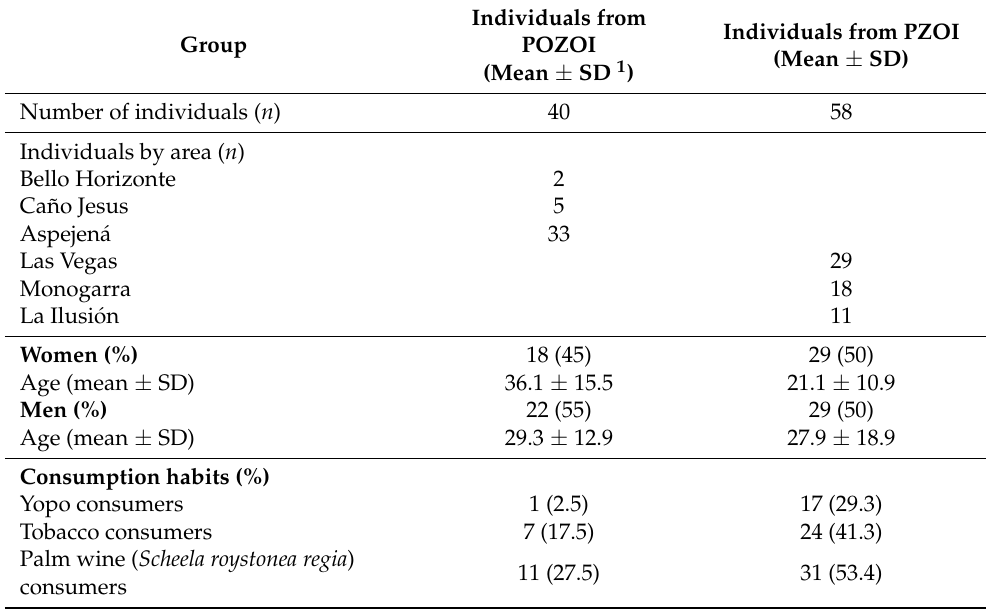
Table 1. Main demographic characteristics of Hitnü indigenous people participating in the study ( n = 98). Individuals from Group